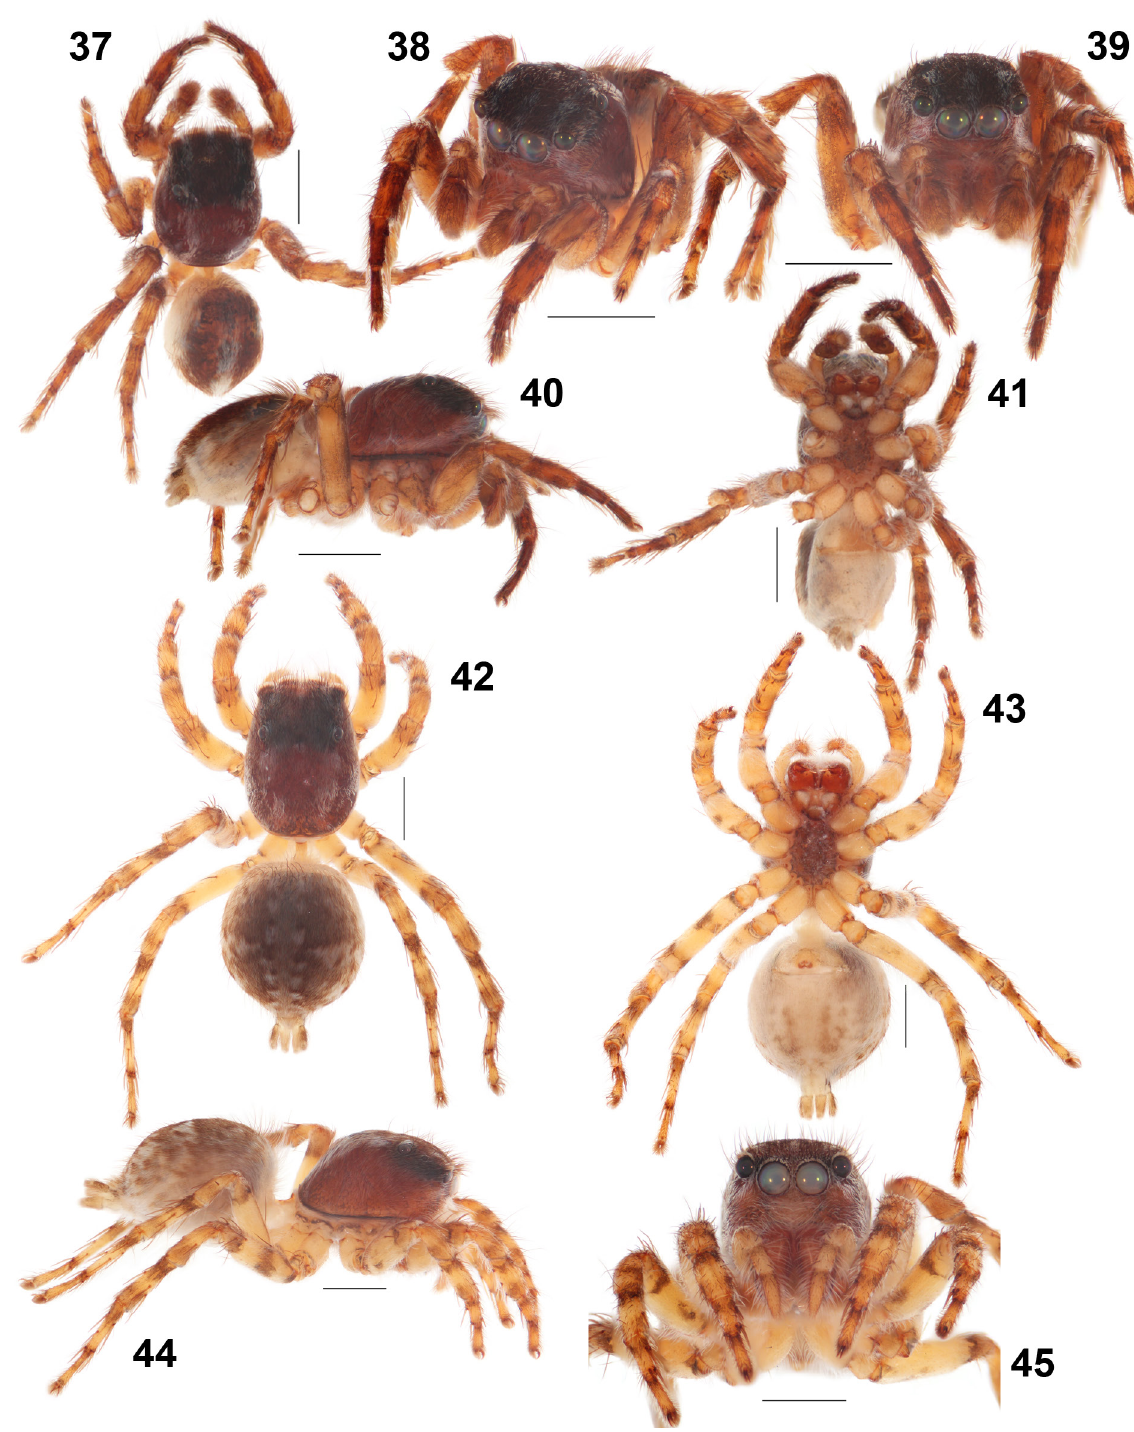
Figs 37–45. Manzuma botswana gen. et sp. nov., holotype, ♂ (37–41) and paratype, ♀ from Moremi GR (42–45), general appearance. Scale bars: 1